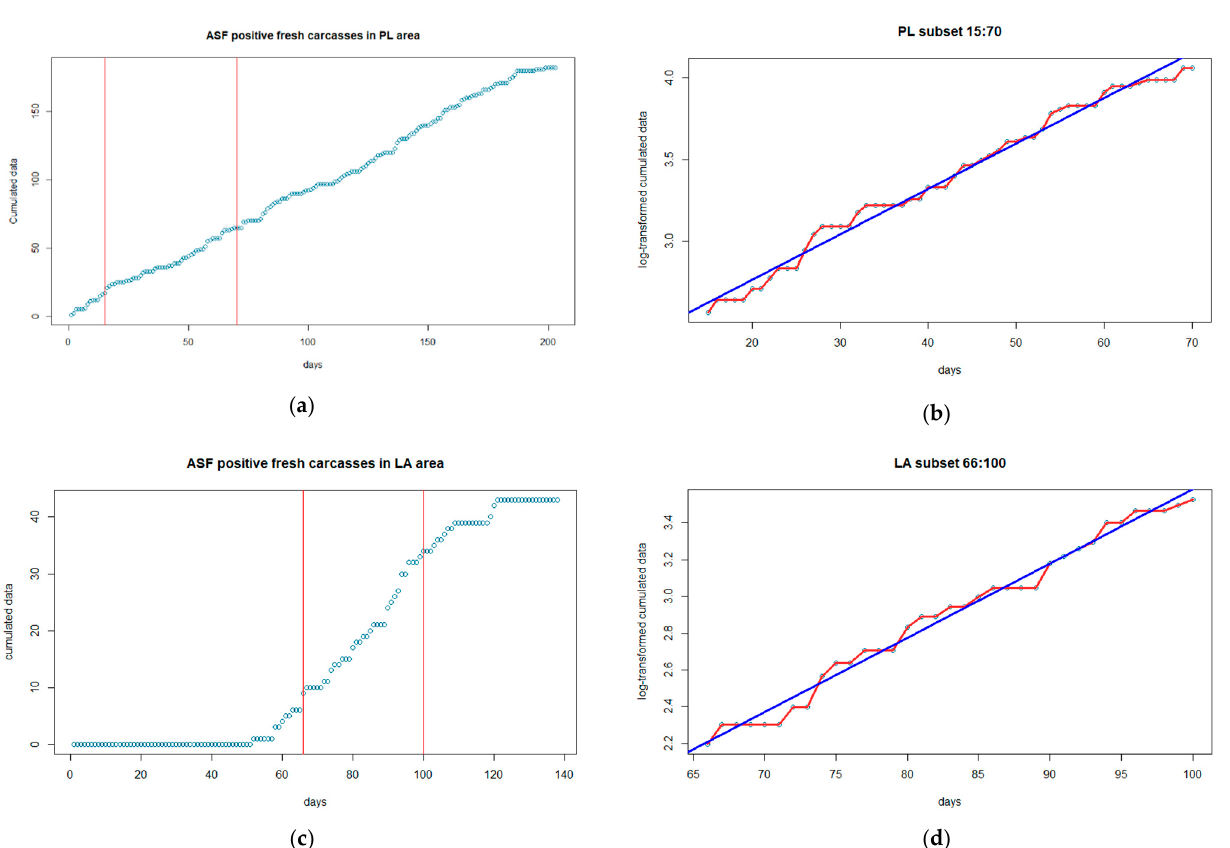
Figure 4. Subset selection: ( a ) subset selected for PL data, including observational times 15:70 (from 26 January to 22 March 2022), based on cumulated data of ASF-positive fresh carcasses; ( b ) linear model fitting based on the log-transformed cumulated data from the PL subset 15:70; ( c ) selected subset for LA data, including observational times 66:100 (from 15 May to 19 June 2022), based on cumulated data of ASF-positive fresh carcasses; ( d ) linear model fitting based on the log-transformed cumulated data from the LA subset 66:100.